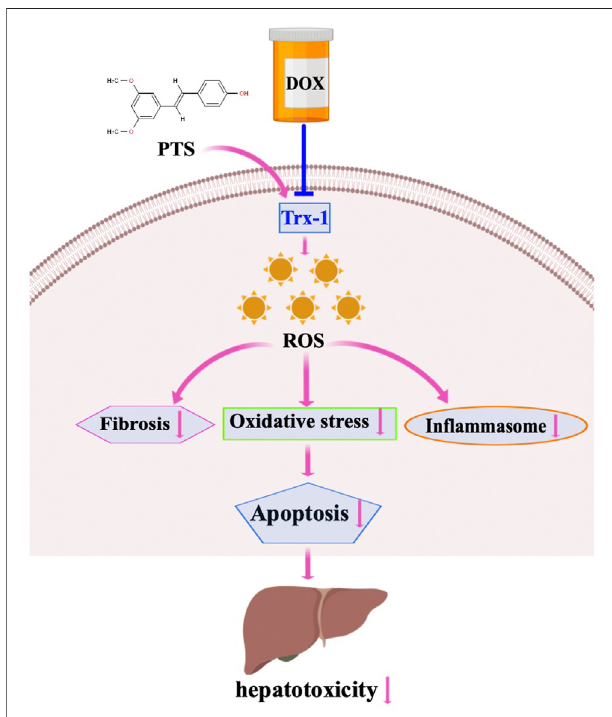
FIGURE 7 | Working model for PTS in the regulation of DOX-induced hepatotoxicity. DOX treatment induced fi brosis, oxidative stress and in fl ammasome stimulation which resulted in hepatotoxicity through downregulation of Trx-1. PTS is able to reduce fi brosis, oxidative stress, and in fl ammasome stimulation through increasing Trx-1 levels. PTS may be used as an agent to protect against DOX-induced hepatotoxicity.